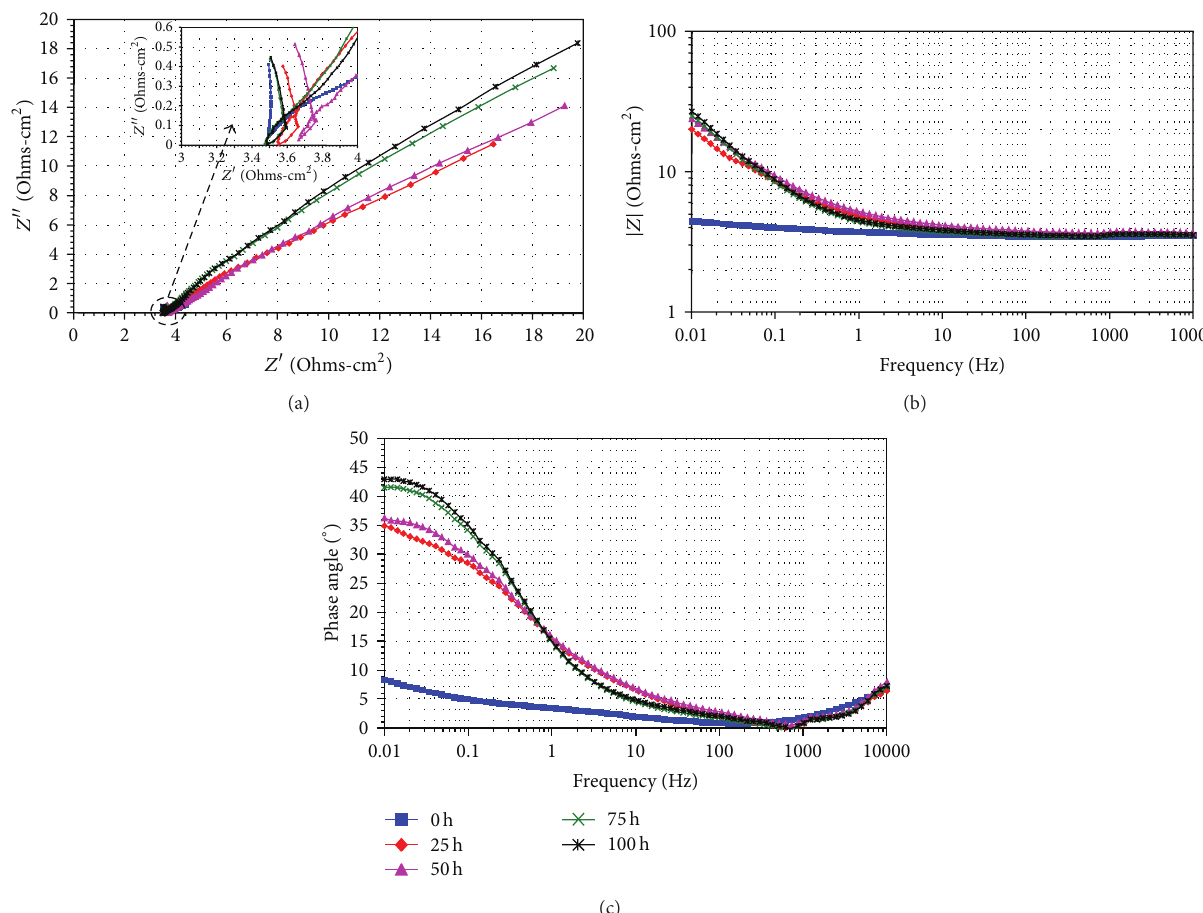
Figure 1: Evolution of the Nyquist and Bode plots of the EIS response of the Fe in NaVO 3 at 700 ∘